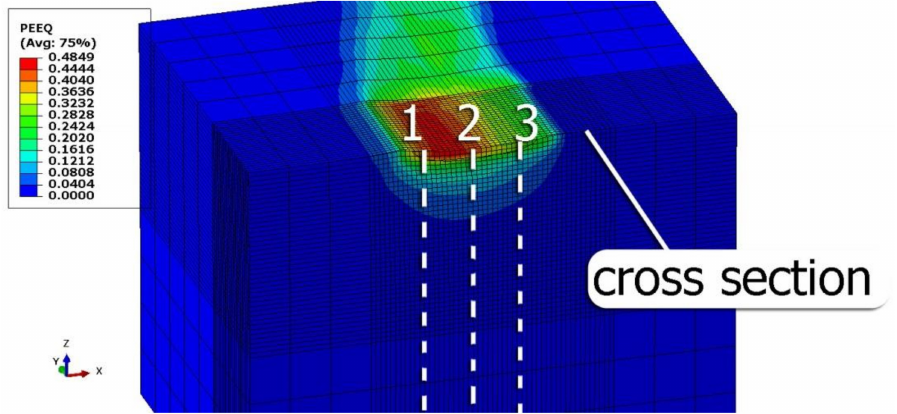
Figure 4. Method of creating paths for determining the residual stresses in the surface